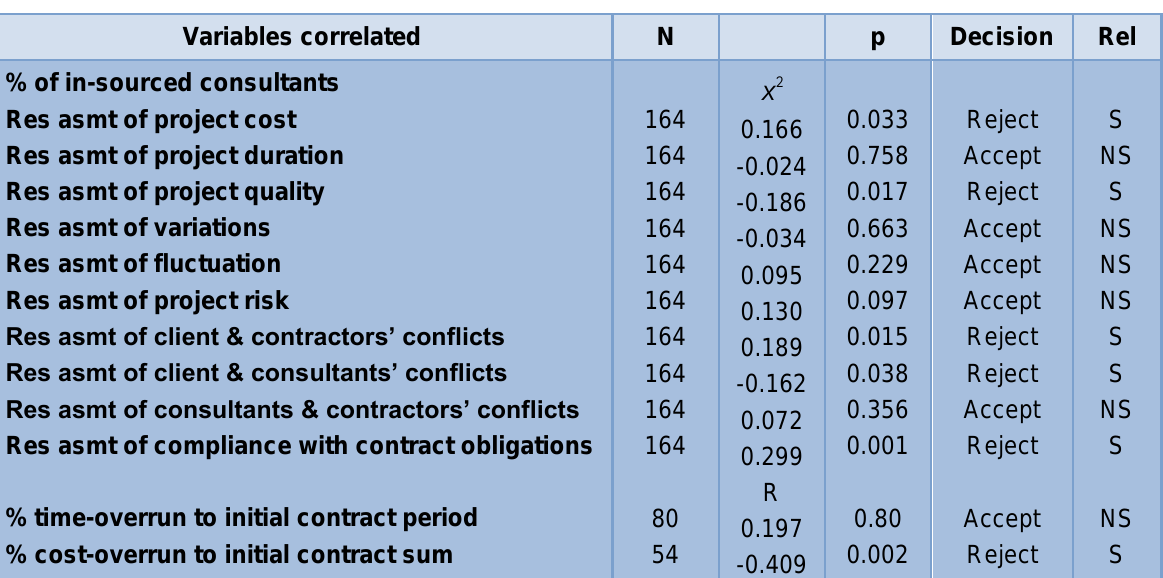
Table 4 Results of Spearman test of correlation between the use of in-sourced and outsourced consultants and project